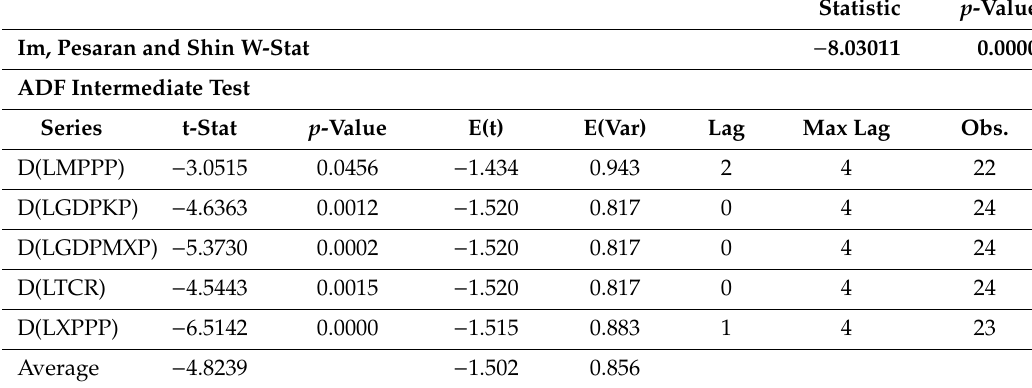
Table 12. Im–Pesaran–Shin Unit Root Tests in First Di ff erences.